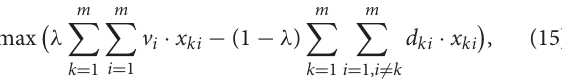
applied to the central restricted area. The two white areas of the image represent parts of the feasible region for the new activity which have been removed because of two distance constraints involving that specific area [a minimal (12) and a maximal (11) constraint]. As a consequence, the solutions B and C are no longer feasible solutions, as they are not located totally inside the remaining feasible region. The same procedure is applied to other areas, ports, and shipping lanes until the final feasible region is